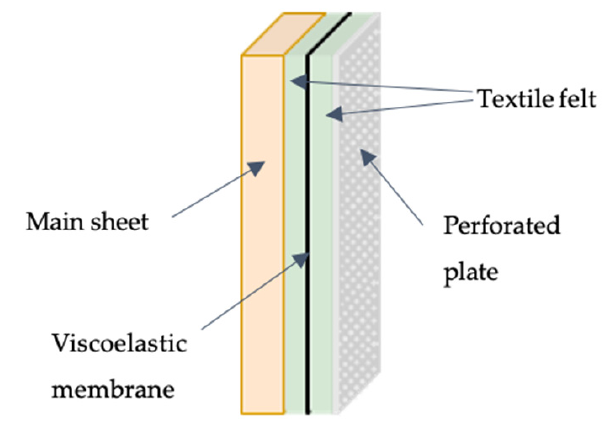
Figure 1. Overview of the proposed solution.